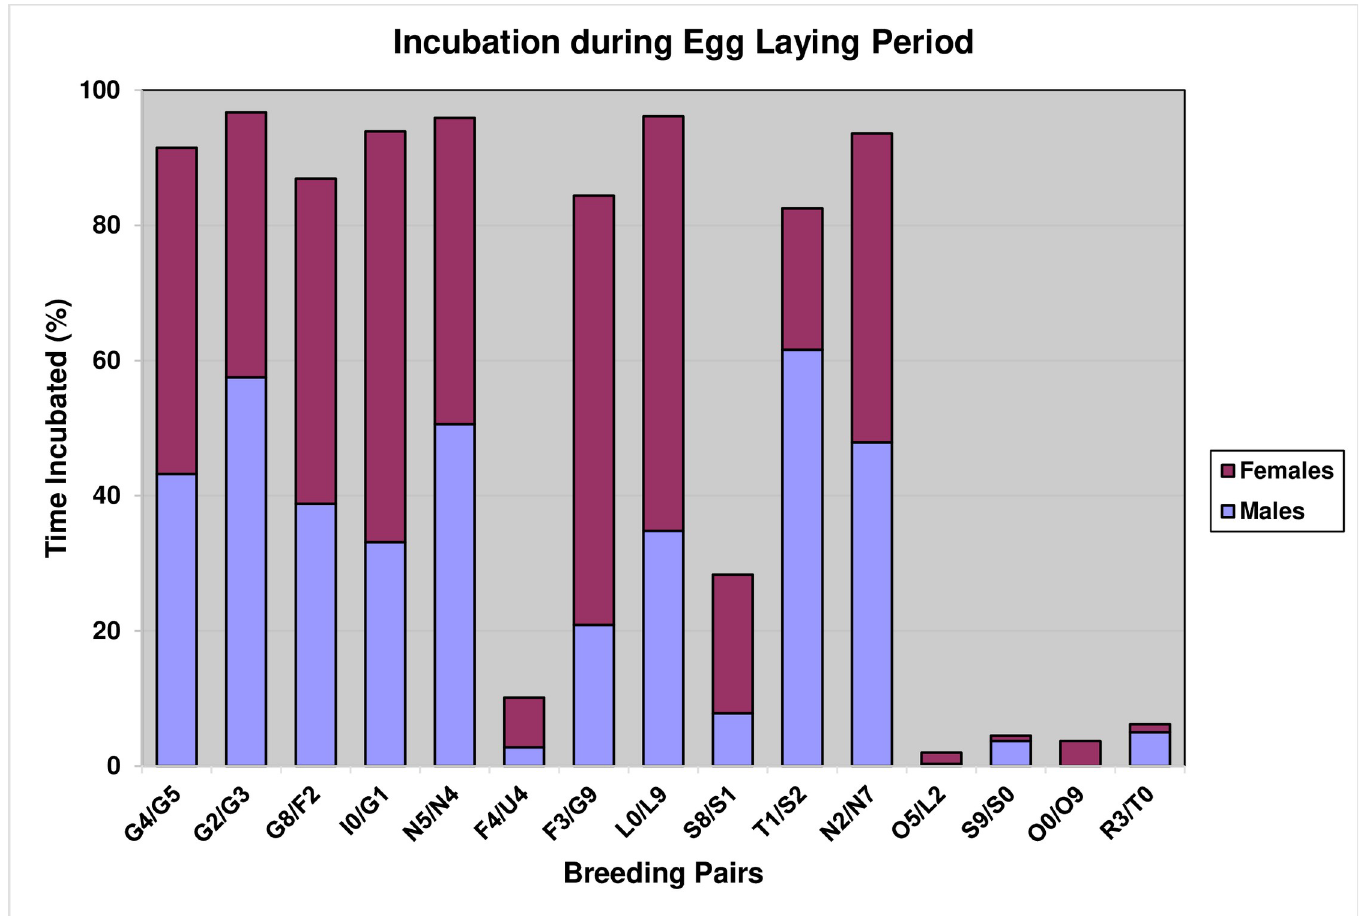
Fig 8. Percentage of time males and females in 15 nests spent incubating the A-egg prior to laying of the